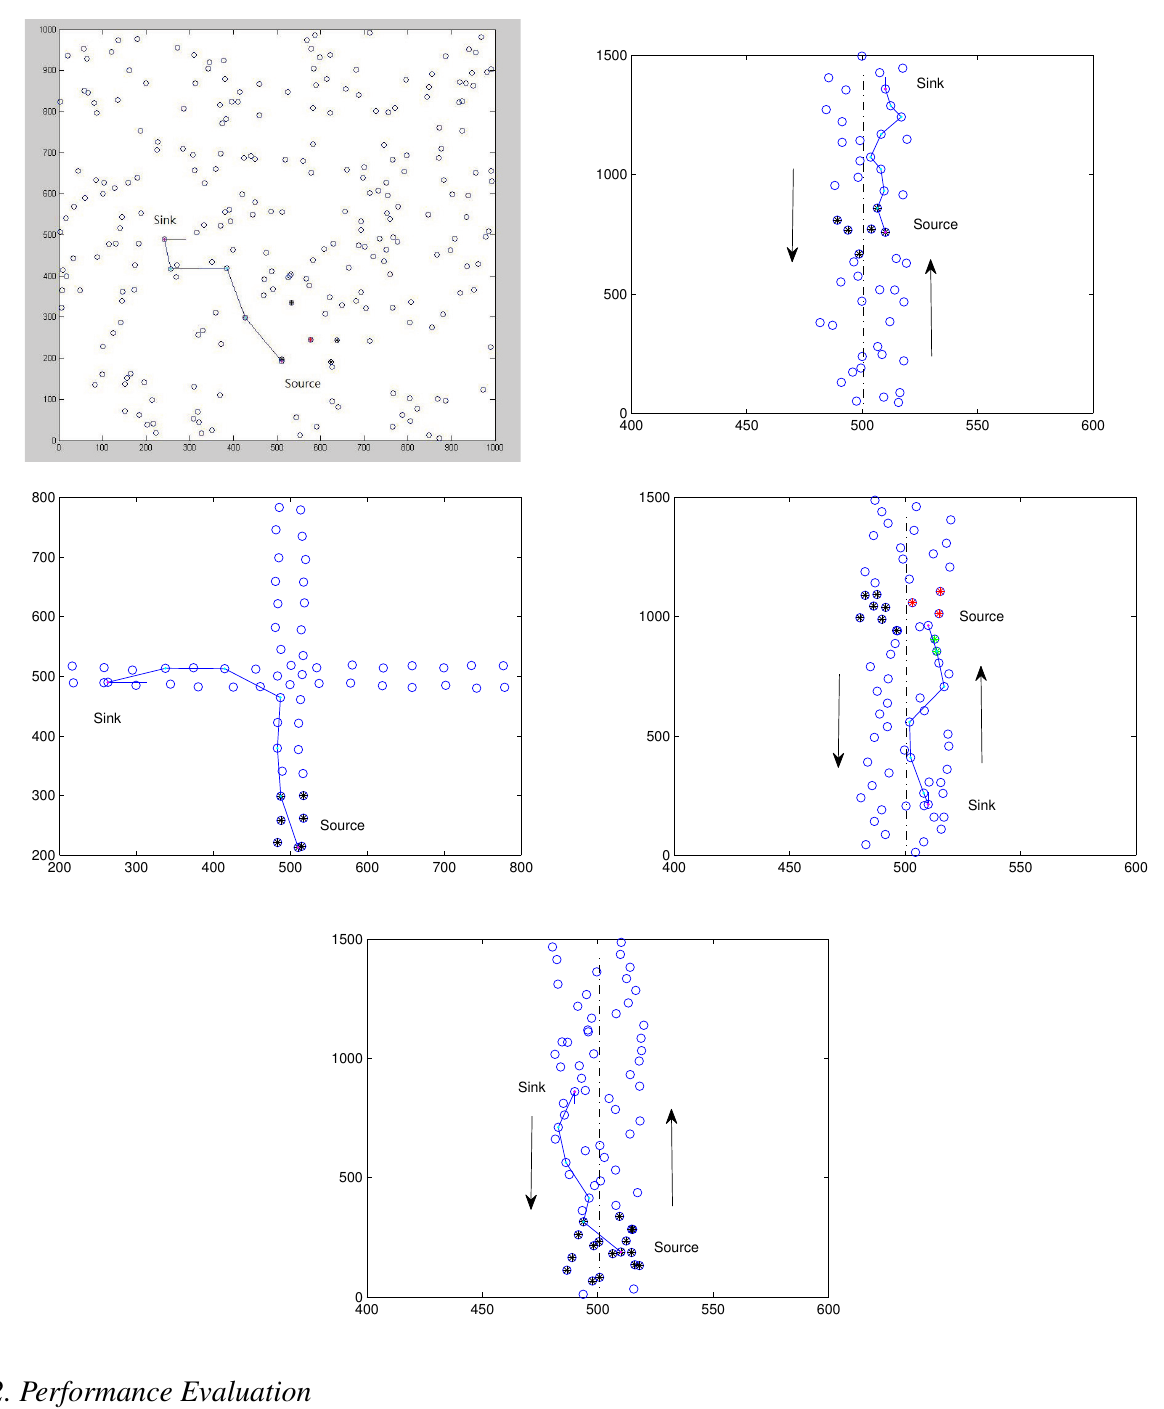
Figure 10. Examples of the HDTC scheme and information routing: Scenario 1 ( Top Left ); Scenario 2, forward propagation ( Top Right ); Scenario 3 ( Middle Left ); Scenario 4, backward propagation ( Middle Right ); and Scenario 5 ( Bottom